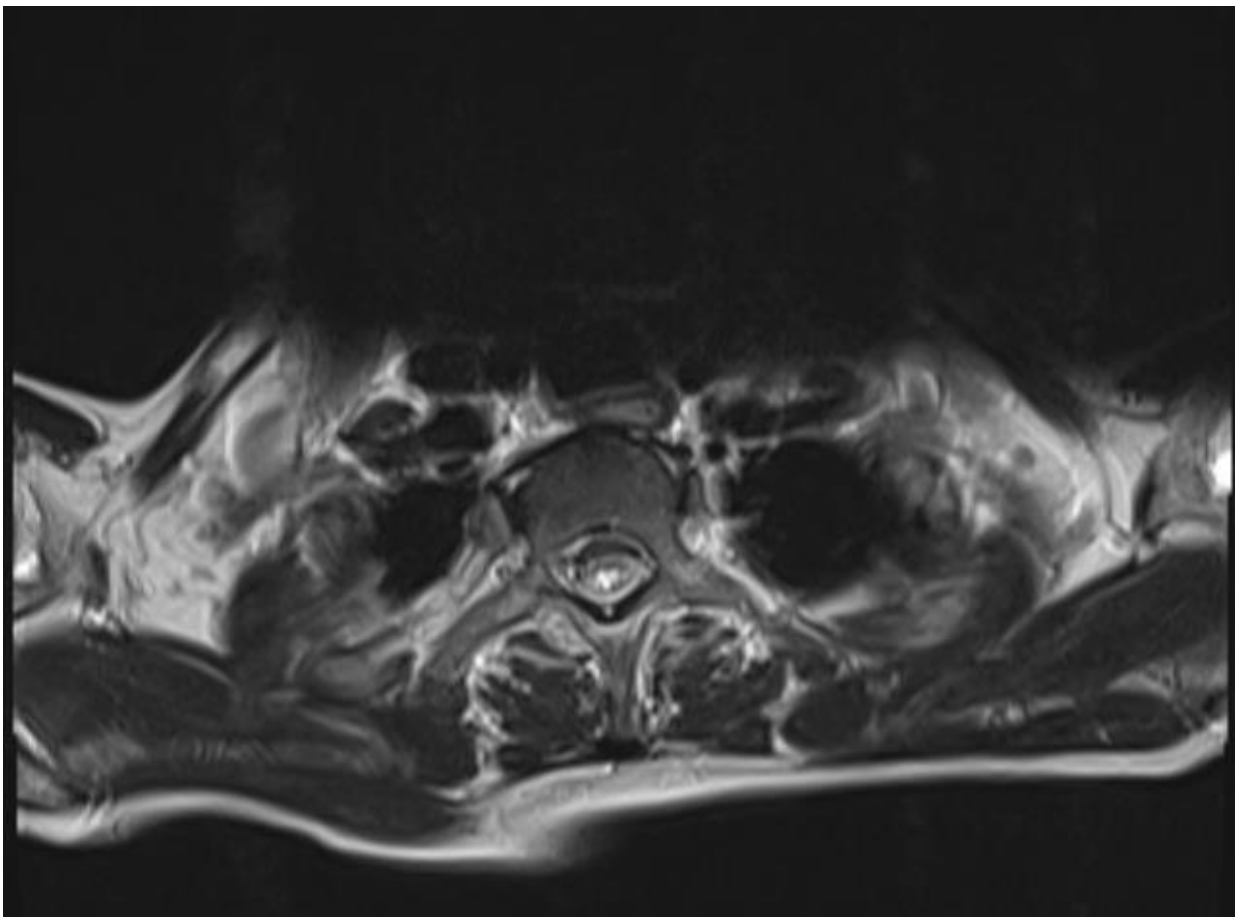
Figure 3. T2-weighted image of the spinal cord: hyperintense lesions in the white matter and in the posterior portion of the spinal cord.